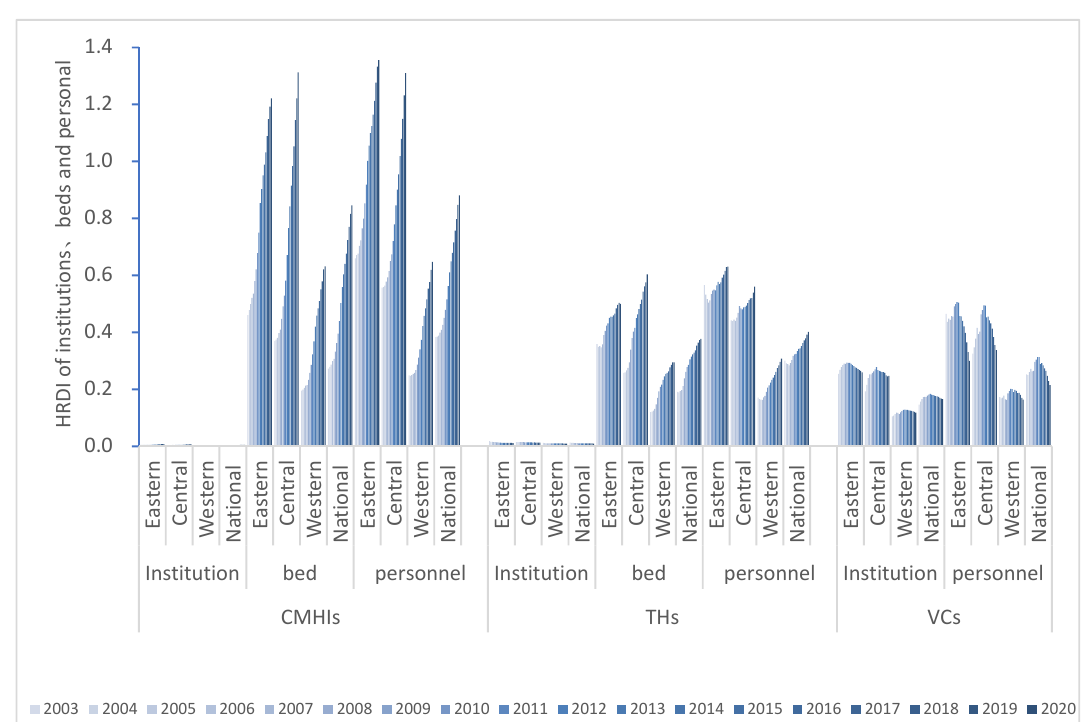
Figure 3. The health resource density index (HRDI) for healthcare resources by Eastern, Central, Western, National in China from 2003 to 2020 (CMHIs: county and county-level city medical and health institutions; THs: township hospitals; VCs: village clinics).